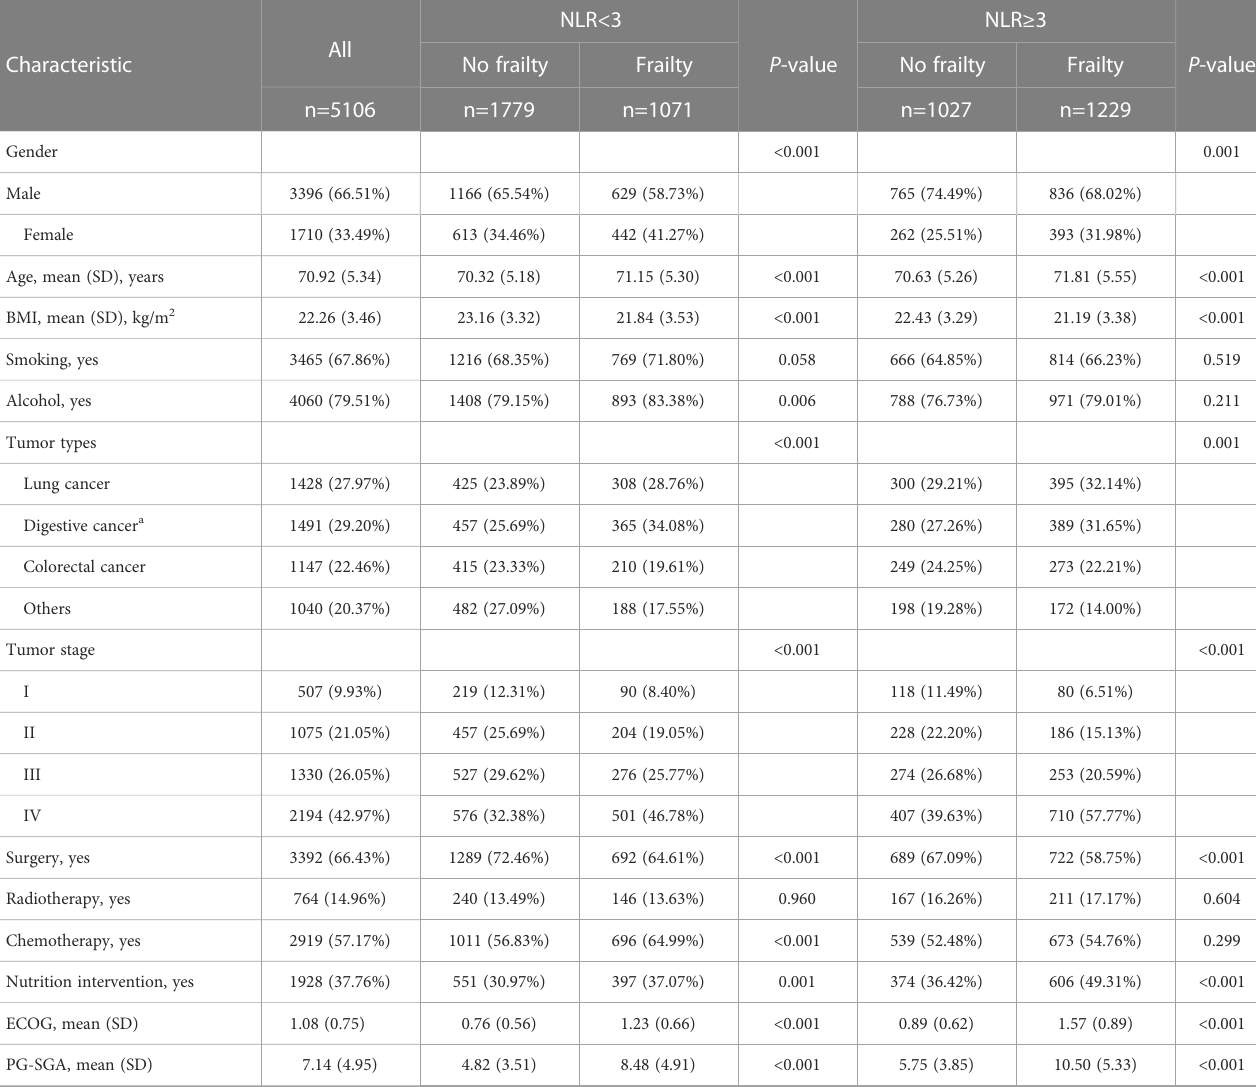
TABLE 1 Characteristics of elderly Patients With Cancer, Overall and by systemic in fl ammation, frailty.